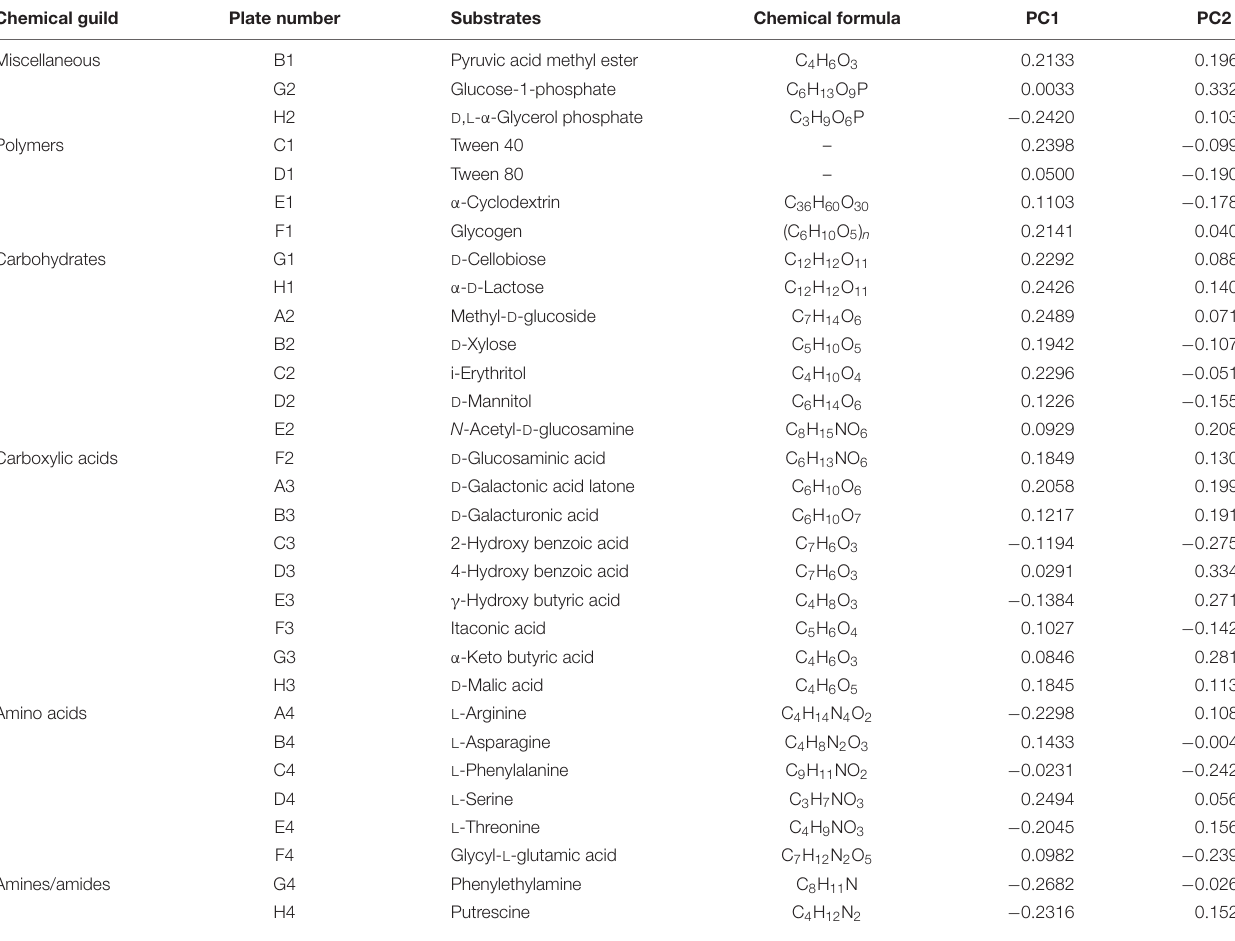
TABLE 2 | The 31 kinds of carbon substrates loaded on the first and second principal component in analysis of BIOLOG ECO microplates data. Chemical